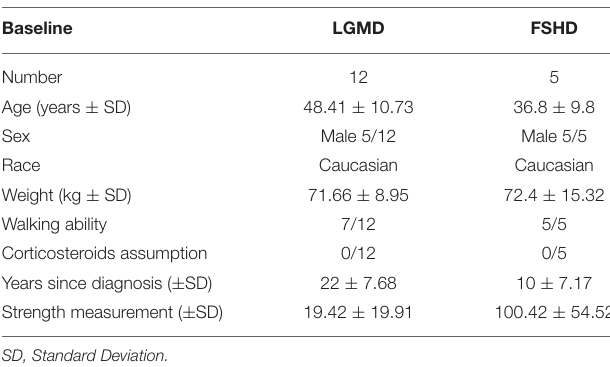
TABLE 3 | OD patients features at baseline.